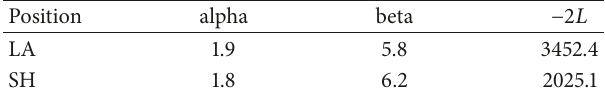
Table 4: Results of parametric